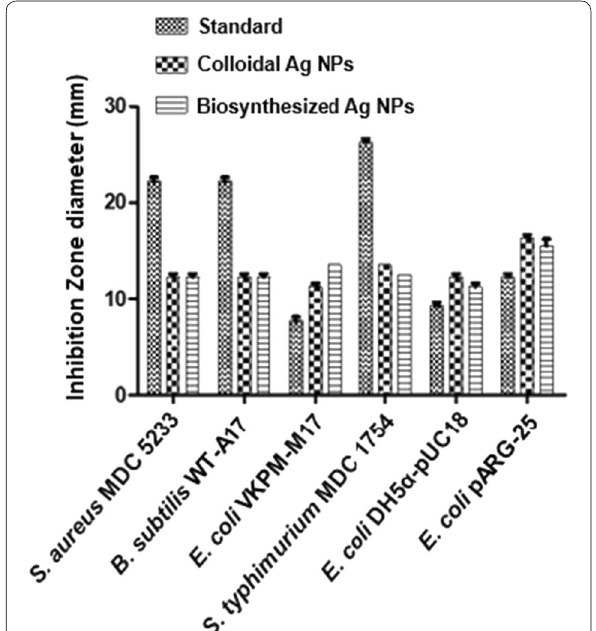
Fig. 6 Antibacterial activity of the Ag NPs 3, colloidal Ag NPs and standards against the test bacteria. See the text